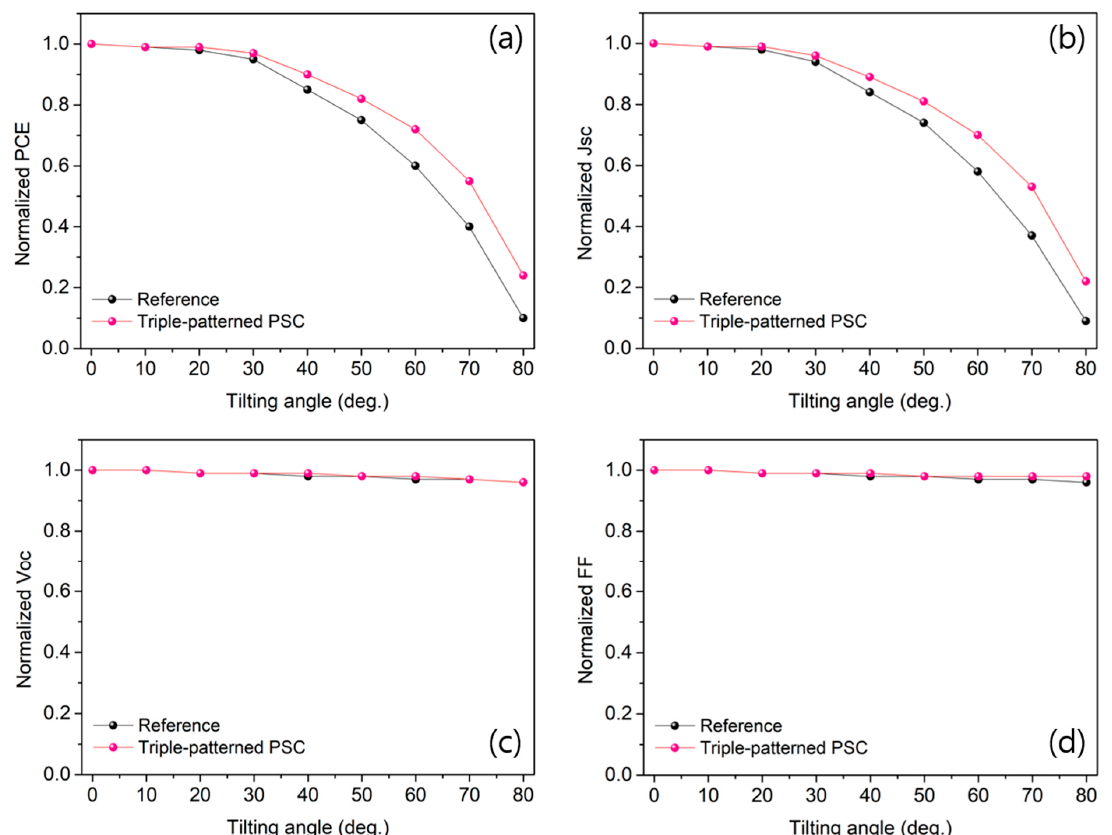
Figure 6. Incident angle dependence characteristics of triple-patterned ultrathin PSC and non-patterned ultrathin PSC. Normalized values of ( a ) power conversion efficiency (PCE), ( b ) short circuit current density (J SC ), ( c ) open-circuit voltage (V OC ), and ( d ) fill factor (FF) as a function of incident light angle.